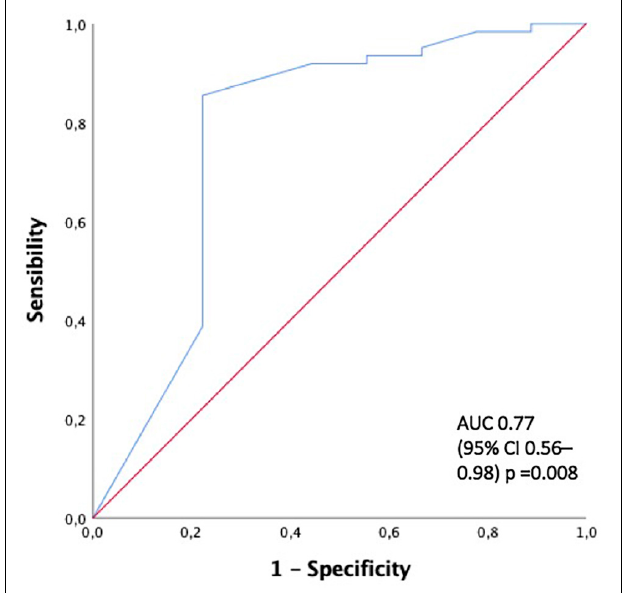
FIGURE 3 | The ROC curve for predicting end-renal stage disease development with creatinine al presentation > 4.7 mg/dl. AUC area under the curve, ROC curve receiver-operating characteristic curve.